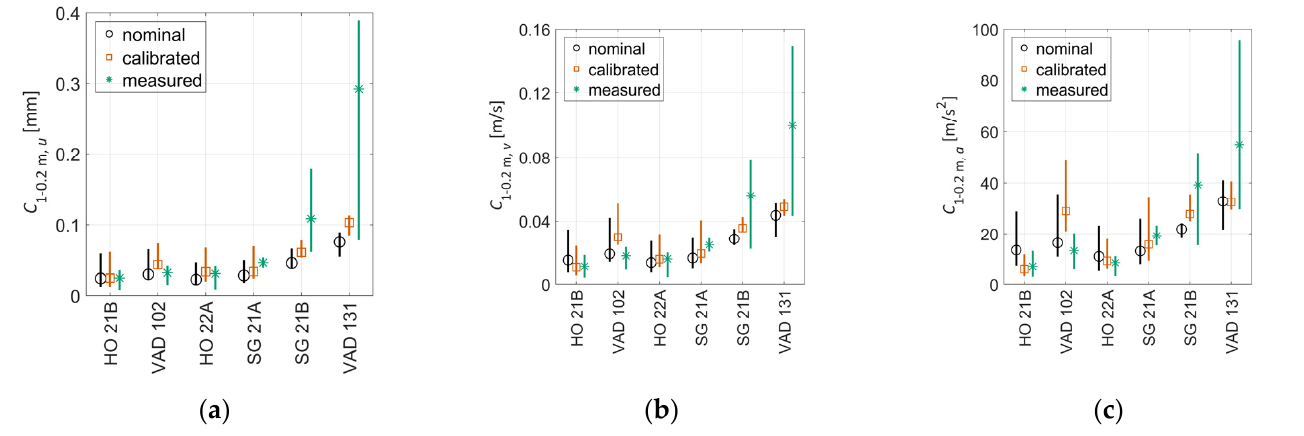
Figure 22. Comparison of 𝐶 (cid:2869)(cid:2879)(cid:2868).(cid:2870) (cid:2923),(cid:3082) for measured and simulated sleeper responses (mean value marker, full range vertical line) for ( a ) displacement, ( b ) velocity, and ( c ) acceleration. Simulated results concern nominal (o-black) and calibrated parameters ( □ -orange) for analyses with one train speed and 19 different wheel profiles. Measured responses (*-green) consist of 20 signals recorded at speeds similar to simulation train speed. Train speeds are 160 km/h for HO 21B, SG 21A and SG 21B; 190 km/h for HO 22A, VAD 102; and 130 km/h for VAD 131.